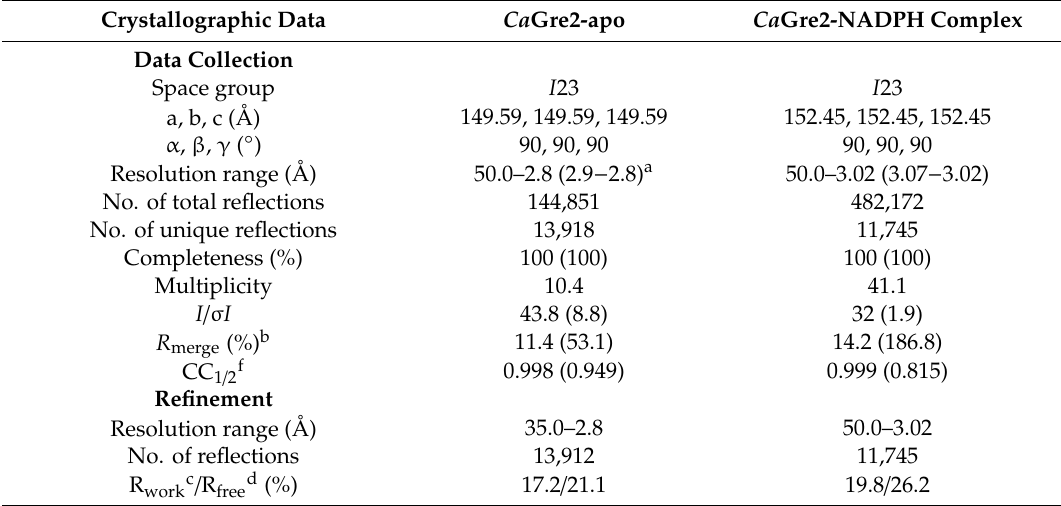
Table 1. Data collection and